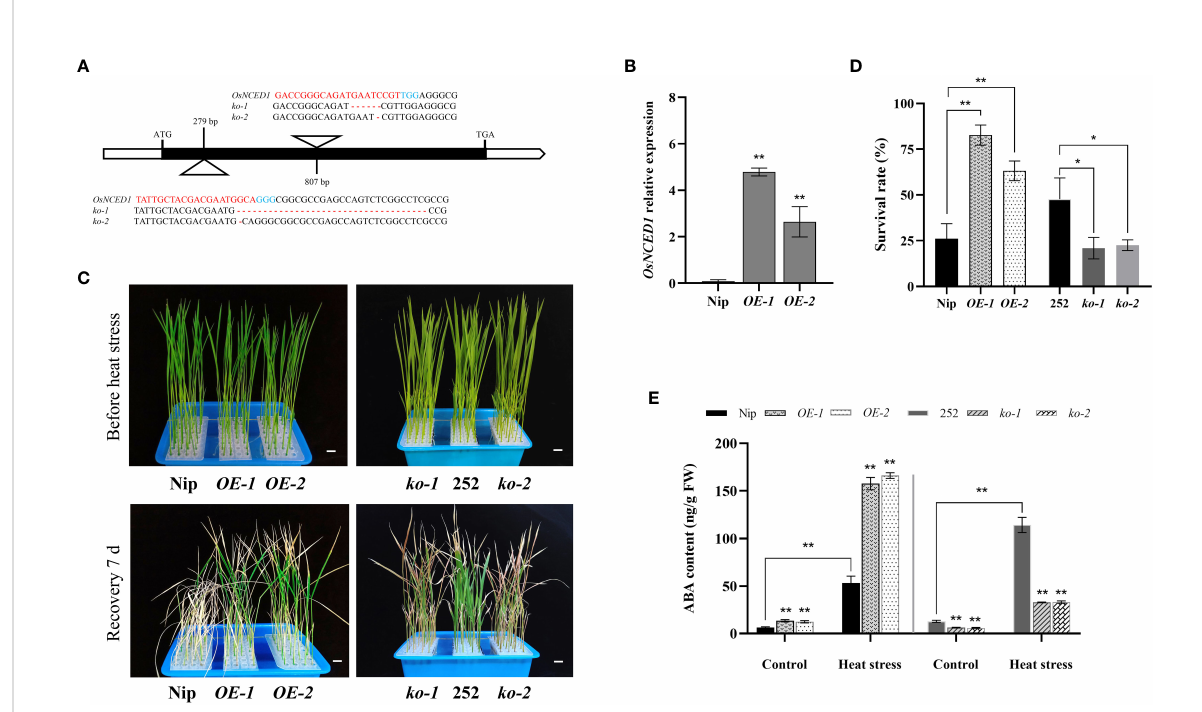
FIGURE 2 Phenotypic analyses of OsNCED1 transgenic lines under heat stress. (A) The diagram of the two CRISPR/Cas9 target sites, and nucleotide mutation sequences of ko-1 and ko-2 lines. The base pairs in blue indicated protospacer adjacent motif (PAM), and the red represented small guide RNA (sgRNA) sequence. (B) Real-time quantitative PCR analysis of OsNCED1 in OsNCED1 overexpression lines OE-1 and OE-2 . Data are means ± SD (n = 3; **P < 0.01, Student ’ s t -test). (C) Phenotypes of two WT and OsNCED1 transgenic rice seedlings before heat stress and 7 days after moderate temperature recovery. Bars = 1 cm. (D) Survival rates (%) of two WT and OsNCED1 transgenic lines after heat stress for 48 h. Data are means ± SD (n = 4; *P < 0.05, **P < 0.01, Student ’ s t -test). (E) Endogenous ABA content in WT and OsNCED1 transgenic lines under control and heat stress. Data are means ± SD (n = 3; **P < 0.01, Student ’ s t